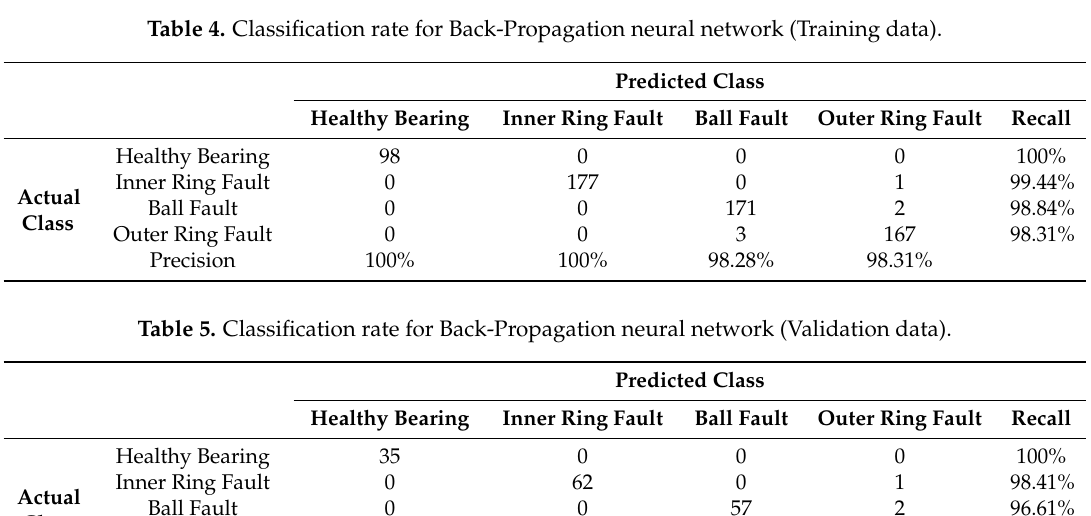
Table 4. Classification rate for Back-Propagation neural network (Training data).